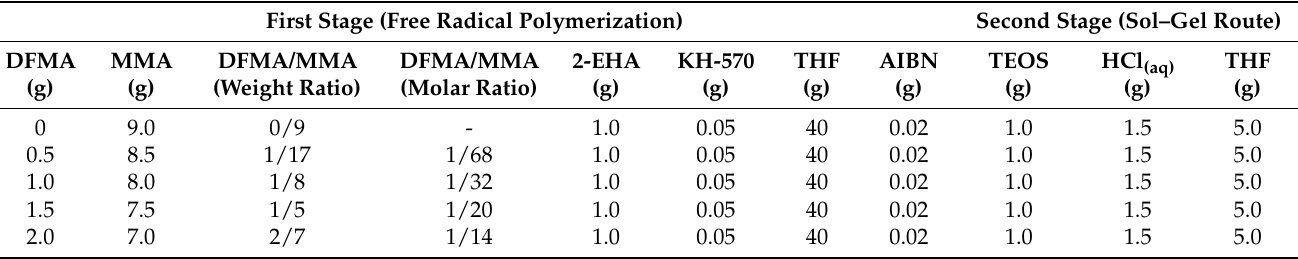
Table 1. The recipes of starting materials for the preparation of the nanohybrid silica polyacrylate coating materials. First Stage (Free Radical